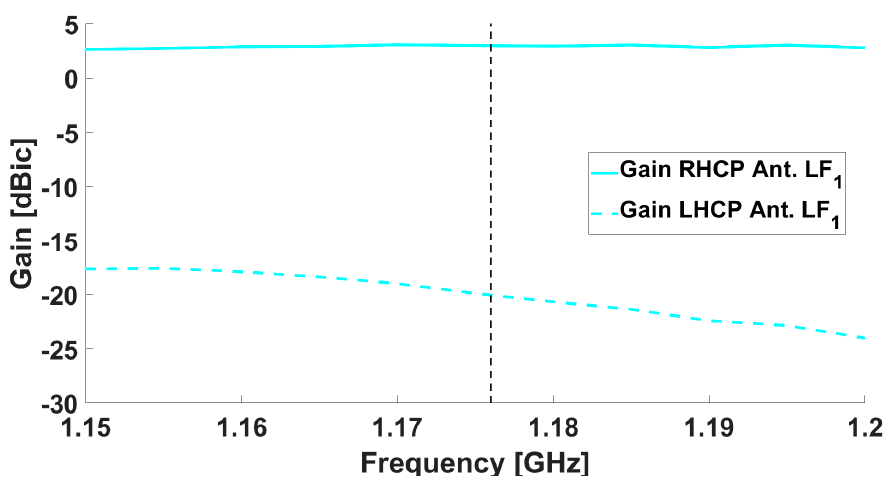
Figure 5. Gain as measured in the Starlab near-field semi-anechoic chamber for the central antenna: the solid line is the RHCP, while the dotted line is the LHCP.